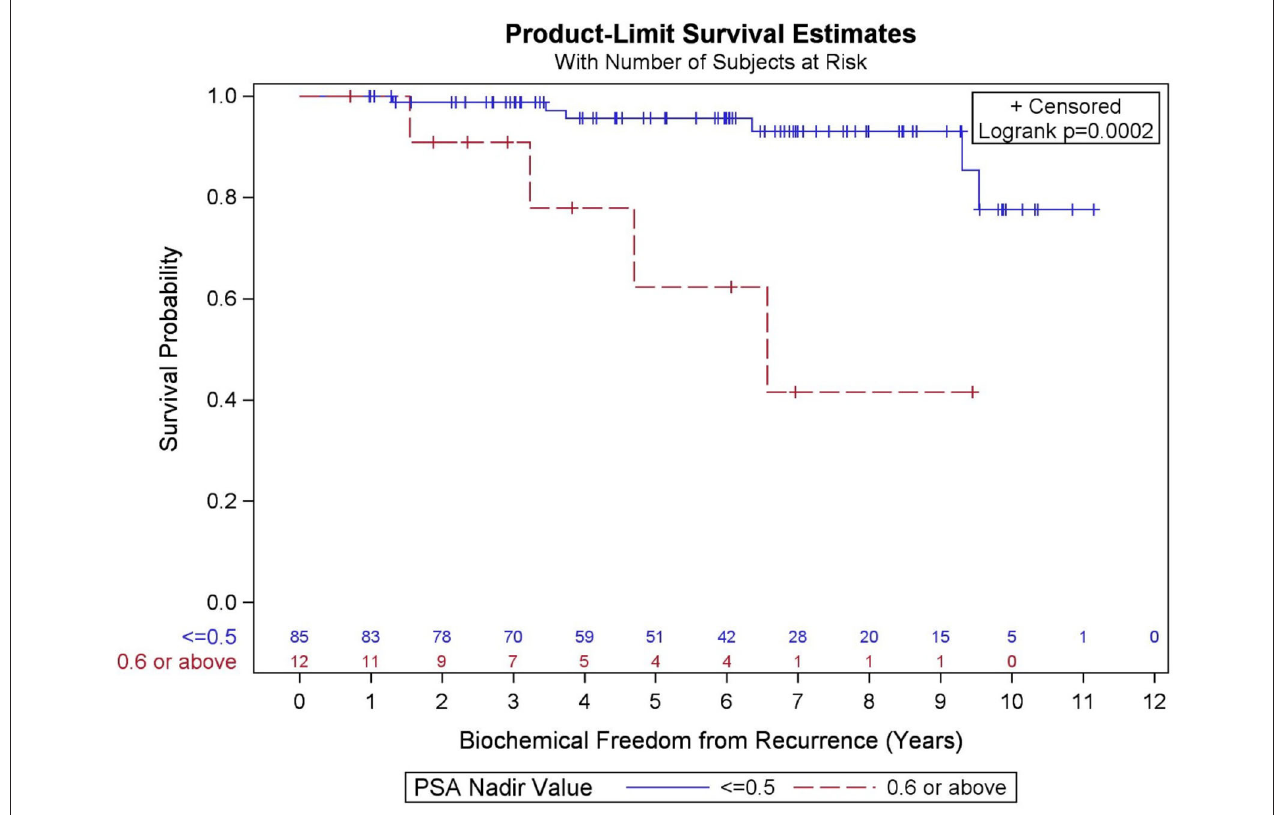
FIGURE 5 | Kaplan–Meier curves for biochemical freedom from recurrence by prostate-specific antigen (PSA) nadir value.